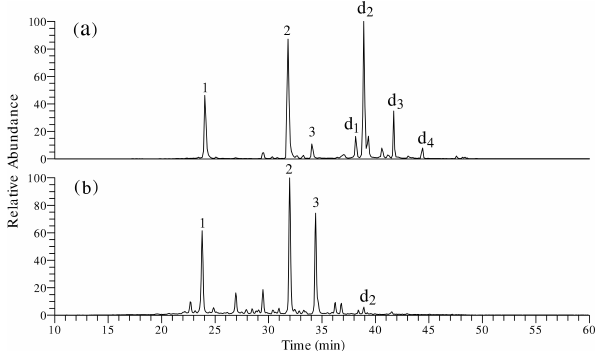
Fig. 2. LC/( − )ESI-MS extracted ion chromatogram (EIC) for (a) laboratory-generated sample from α -pinene/O 3 and (b) pooled night-time ambient summer sample from Hyytiälä, Finland col- lected during 16 to 25 August 2011. The chromatographic peaks correspond to (1) diaterpenylic acid with m/z 171.0662, (2) cis- pinic acid with m/z 185.0818, (3) cis-caric acid with m/z 185.0818, ( d 1 ) dimer with m/z 377.1454, ( d 2 ) dimer with m/z 357.1552, ( d 3 ) dimer with m/z 367.1762 and ( d 4 ) dimer with m/z 337.1652. In the ambient sample (b) only one dimer ( d 2 ) was observed; the other small peaks between 36 and 42min retention time in (b) do not cor- respond to d 1 , d 3 and d 4